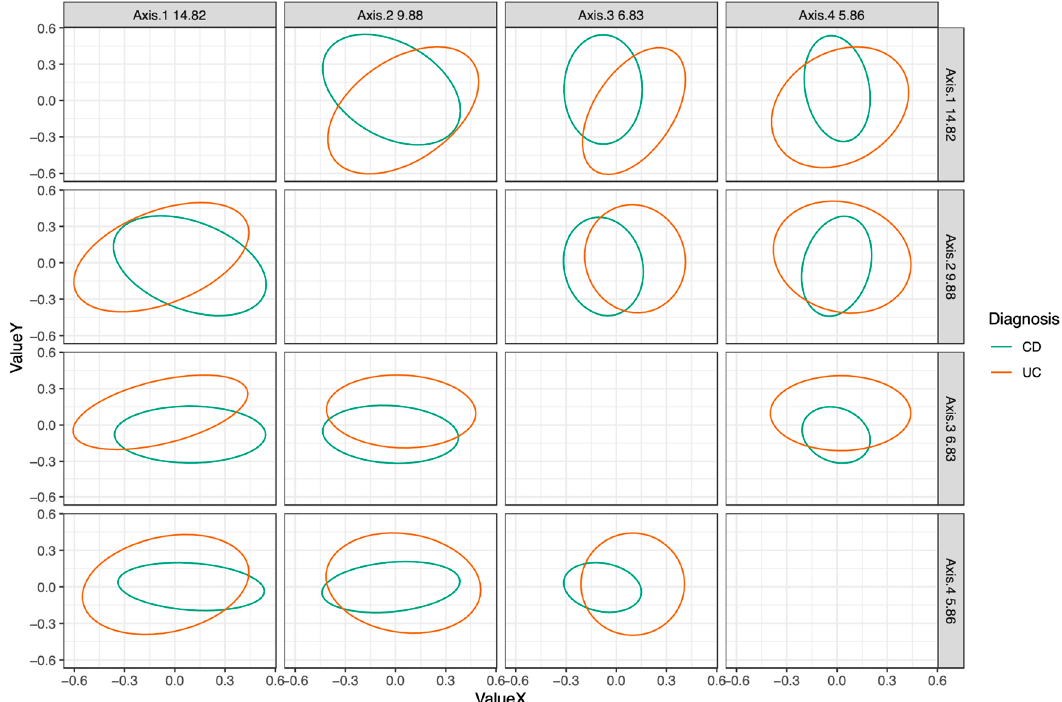
Figure 2. Principal coordinate analysis of CD and UC fecal microbiota at baseline (active disease). Fecal microbiota collected from 20 patients with CD, 10 patients with UC with active disease before the onset of treatment. Bacterial taxa clustered differently between diagnoses. CD—Crohn’s disease, UC—ulcerative colitis.